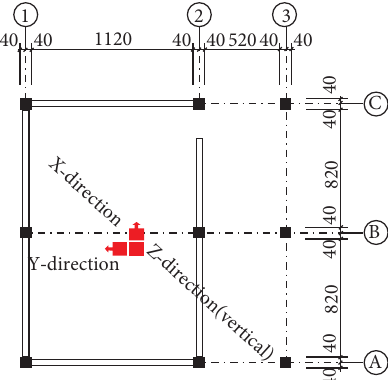
Figure 26: Displacement and acceleration sensor layout position.